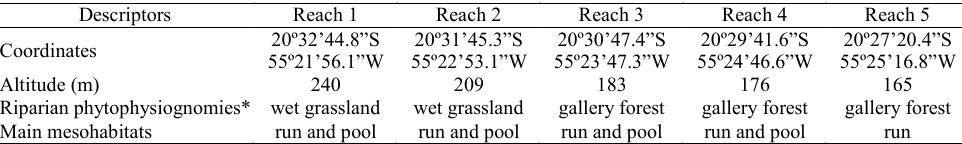
Table 1. Location and general characteristics of reaches (R1-R5) of the Correntes stream, central west Brazil. * sensu Ribeiro & Walter